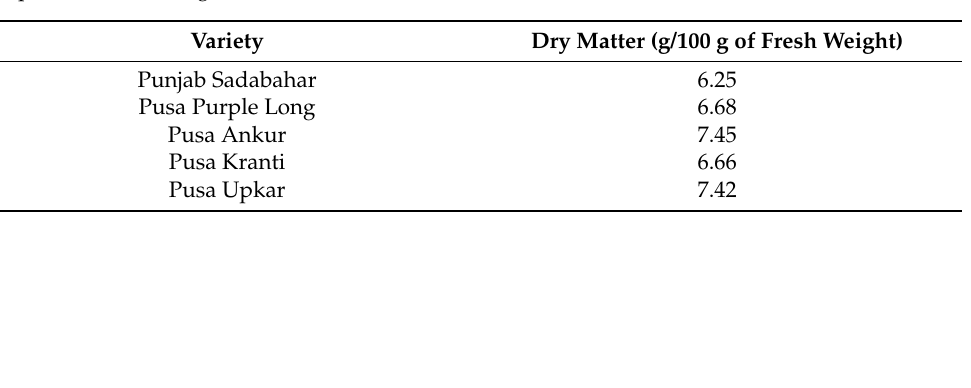
Table 10. Variations in dry matter content in Indian eggplant cultivars in g/100 g of fresh weight adapted from Arivalagan et al.